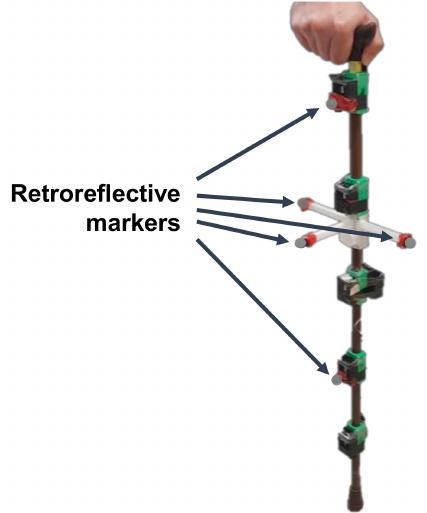
Figure 6. Image of the instrumented cane fitted with retroreflective markers for the optical motion capture